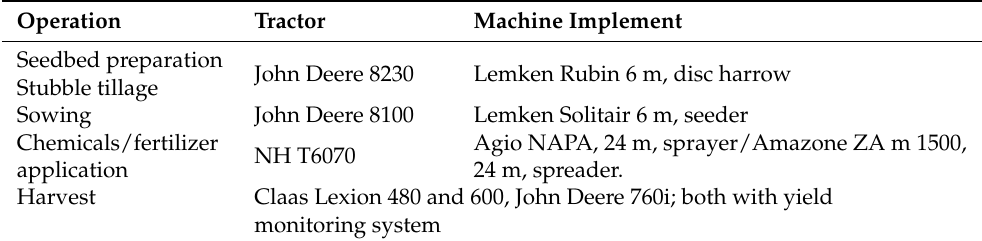
Table 1. Overview of machineries used for field operations.